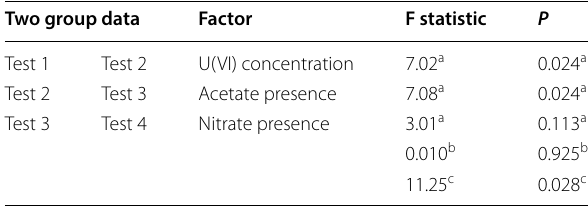
Table 2 ANOVA analysis